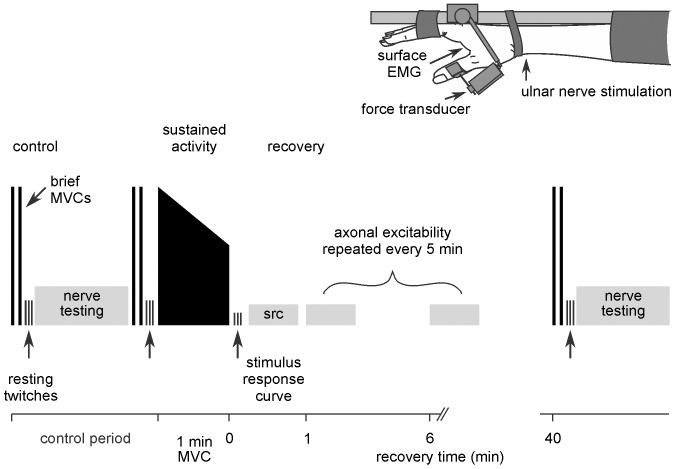
Schematic representation of the experimental setup and protocol.The experimental setup is viewed from above. The experimental protocol (not shown to scale) consisted of a control period, a sustained 1-min adductor pollicis MVC, and the recovery period. The “nerve testing” rectangle represents the TRONDNF protocol. After the stimulus-response curve (src) one component of axonal excitability was measured every 5 min for 40 min through the recovery period in 4 experimental sessions with measures of muscle force in the 5th session.